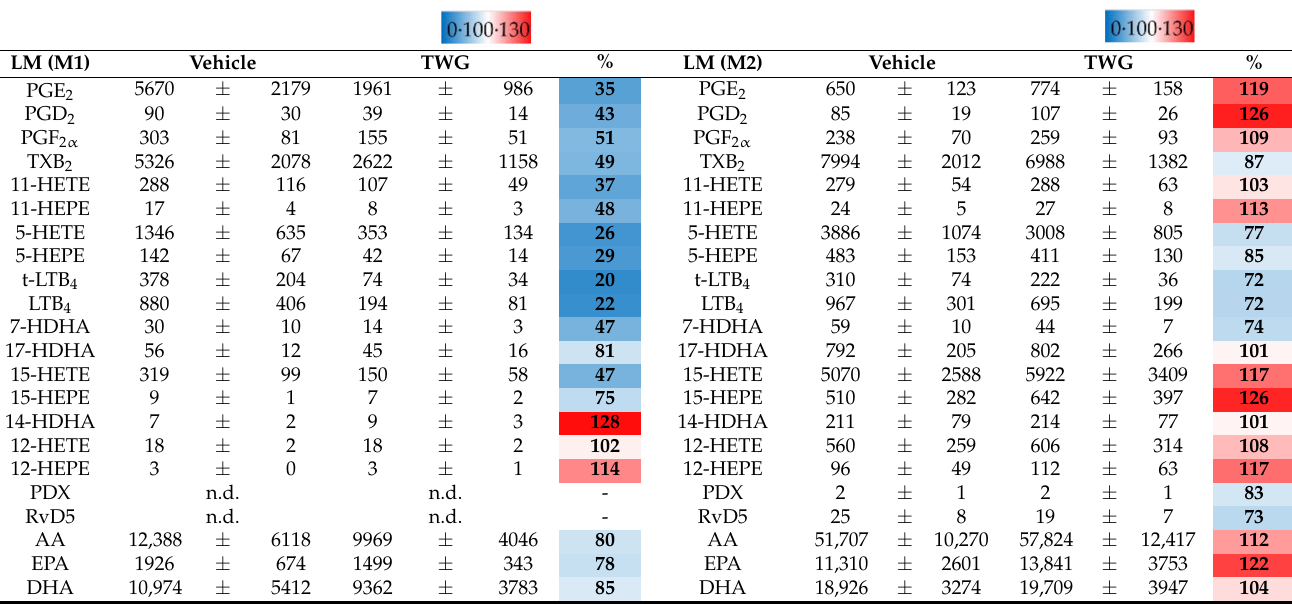
Table 3. Heatmap of LM produced by human M1- and M2-MDM and effects of TWG. M0 GM-CSF and M0 M-CSF MDM were pre-treated with 1 µ g/mL TWG or 0.1% DMSO as vehicle for 15 min prior to polarization toward M1- or M2-MDM for 48 h by the addition of LPS/IFN γ (M1-MDM, left) and IL-4 (M2-MDM, right), respectively. Cells in PBS plus 1 mM CaCl 2 were then stimulated with 1% SACM for 90 min. LM from cells released into the supernatants were extracted and analyzed by UPLC-MS/MS. Data are means ± S.E.M., n = 5 (both M1-MDM and M2-MDM); n.d., not